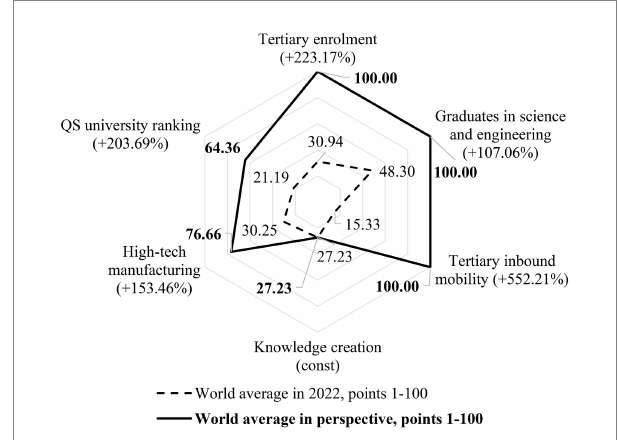
FIGURE 1 Prospects for strengthening strategic academic leadership and